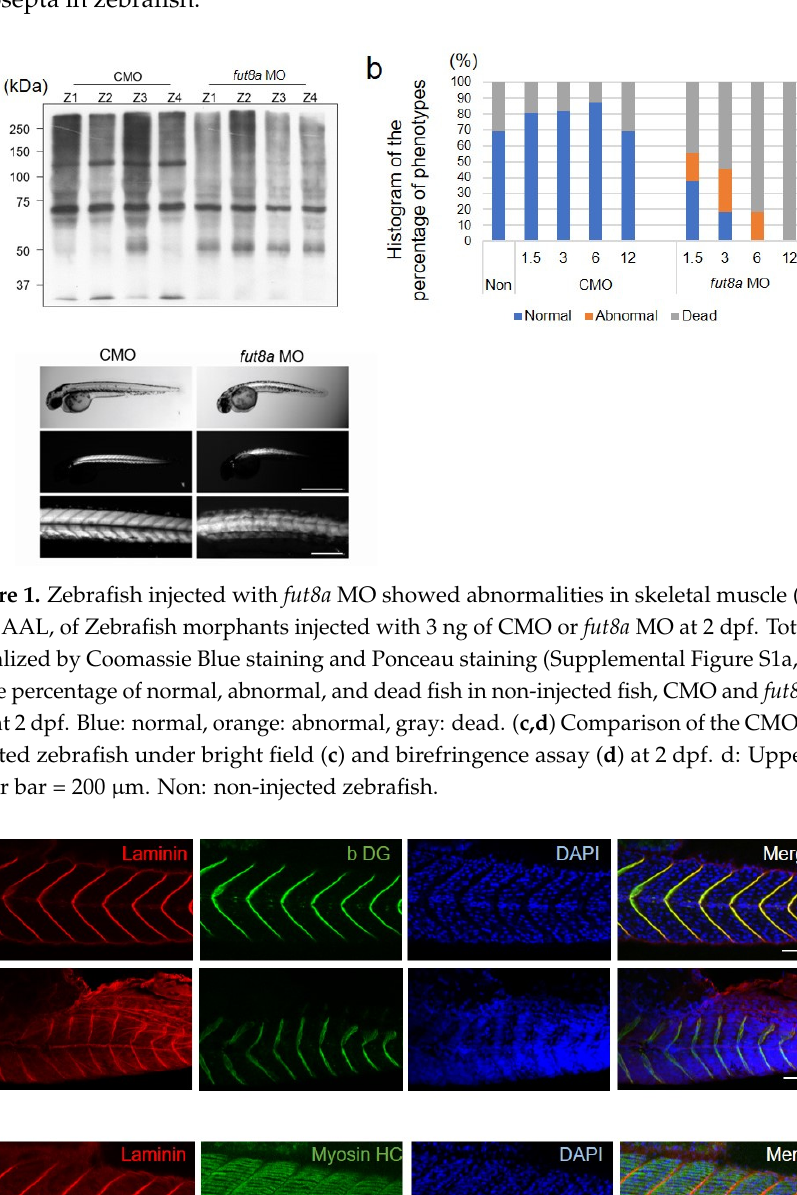
Figure 3. fut8a reduction causes structural abnormalities in myosepta ( a ) Left panel is CMO, right panel is fut8a MO. The white dotted line indicates the angle between the dorsal vertical and trans- verse myoseptas, and the double arrow indicates the distance of the transverse myoseptas, stained with anti-laminin. Scale bar: 50 μ m. ( b ) Histogram of the angle between the vertical and transverse myoseptas. ( c ) Histogram of the variation in sarcomere length. Five to ten sarcomere lengths were calculated from five fish. CMO: Median 1.956, Max 2.032, Min 1.869. fut8a MO: Median 2.0325, Max 2.153, Min 1.772 ( t -test. p < 0.01, n = 5).